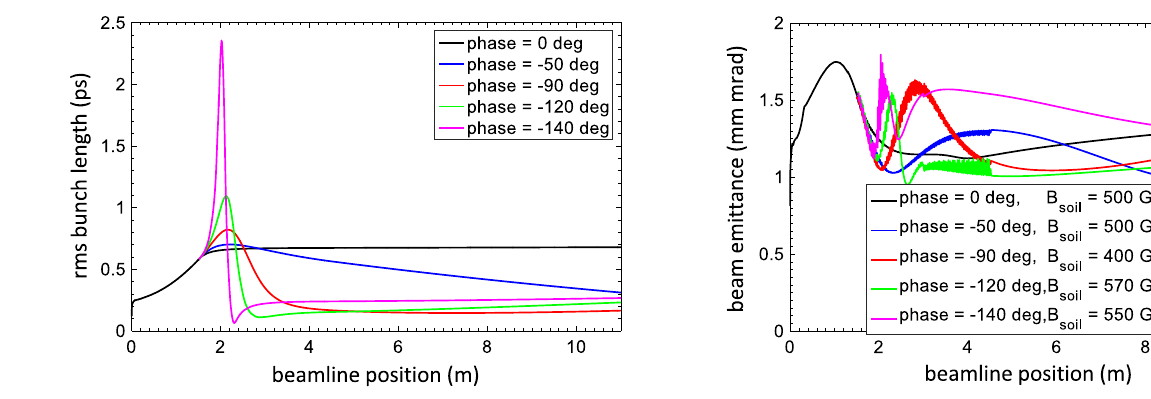
FIG. 4. Simulated emittance evolution along the beamline, with emittance compensation by tuning the long solenoid strength under different TWA